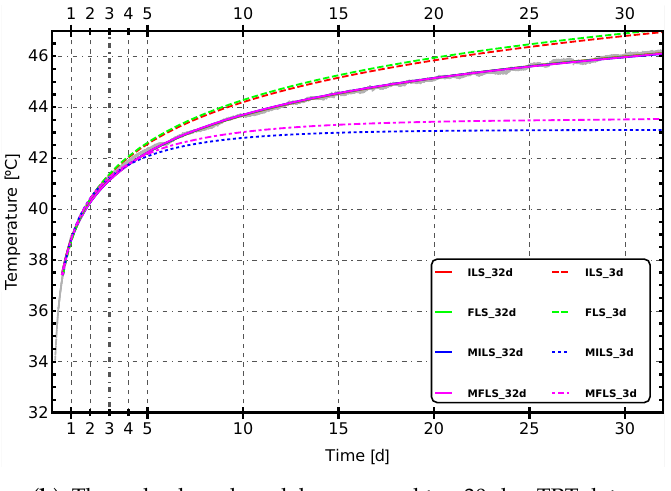
Figure 2. Comparison of experimental mean BHE temperatures (gray area) vs. the prediction of four different calculation models. In a standard TRT, the model parameters are estimated using only the first three days of test (72 h), which give the comparison graph shown in (a). In (b), the same three-day based models are compared to models fitted from the whole data of a 32-day experiment and the raw